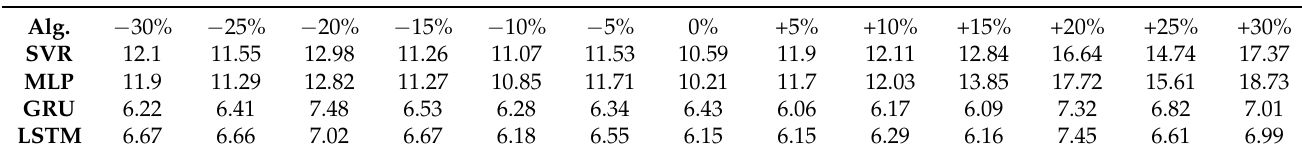
Table 1. Comparison of the mean absolute error for different variations in the sensitivity parameter with respect to the regression algorithm.